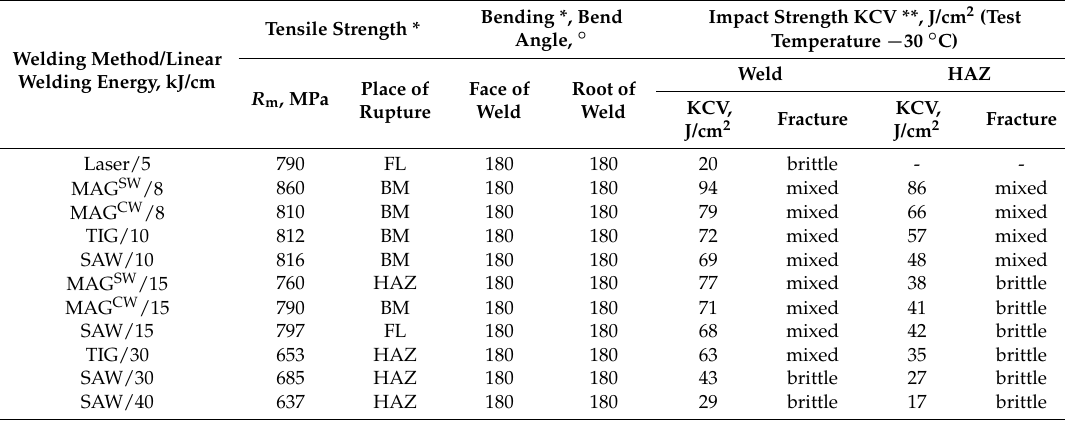
Table 2. Effect of welding and heat input on the mechanical and plastic properties of welded joints. Bending *, Bend Tensile Strength * Angle, Welding Method/Linear Welding Energy, kJ/cm